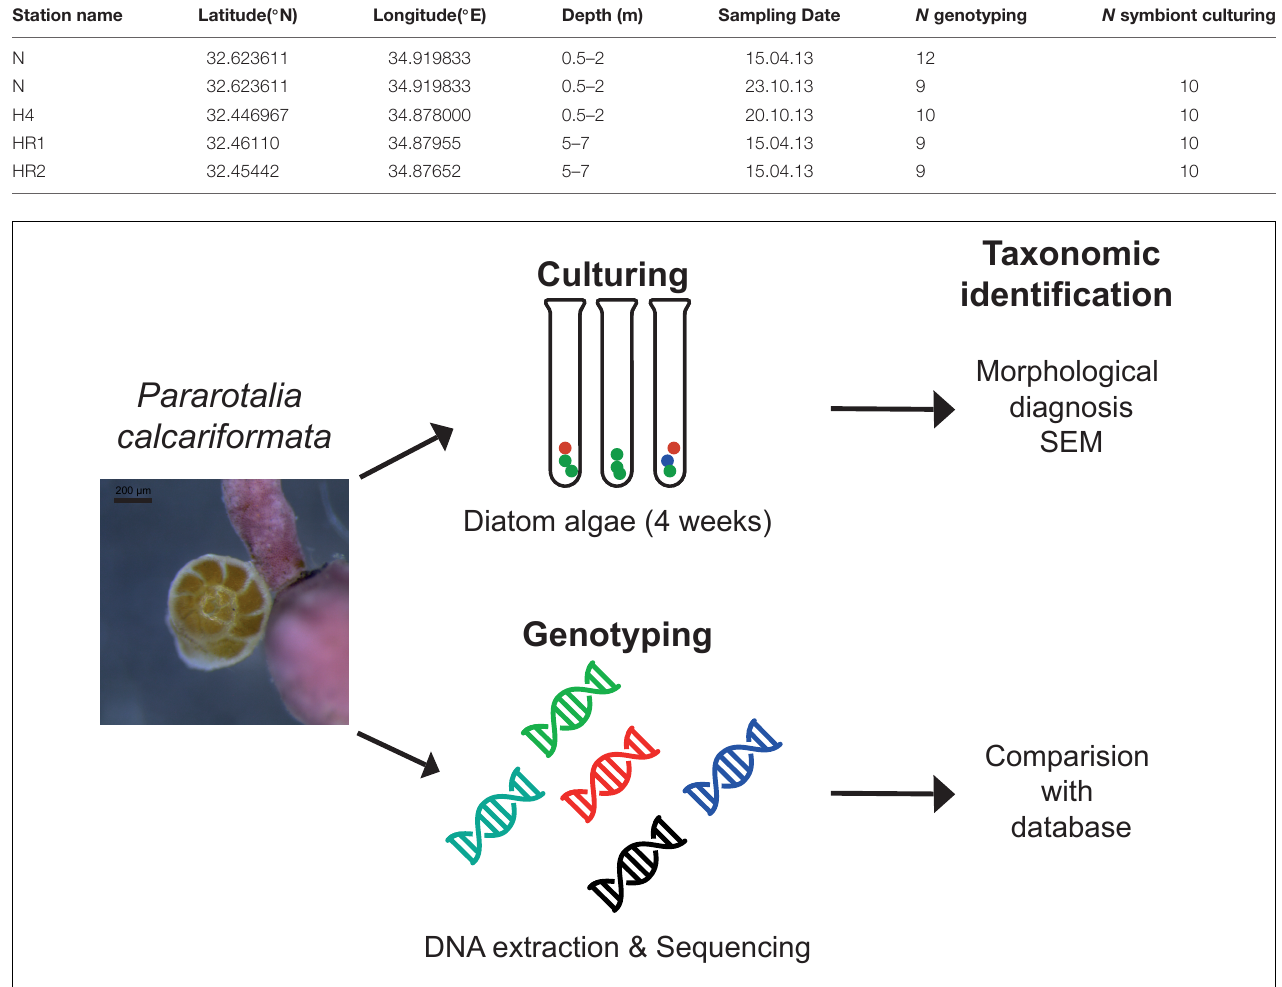
FIGURE 2 | Methodological approach isolating the diatom symbiont community of benthic foraminifera with the standard culturing approach and genotyping as conducted in this